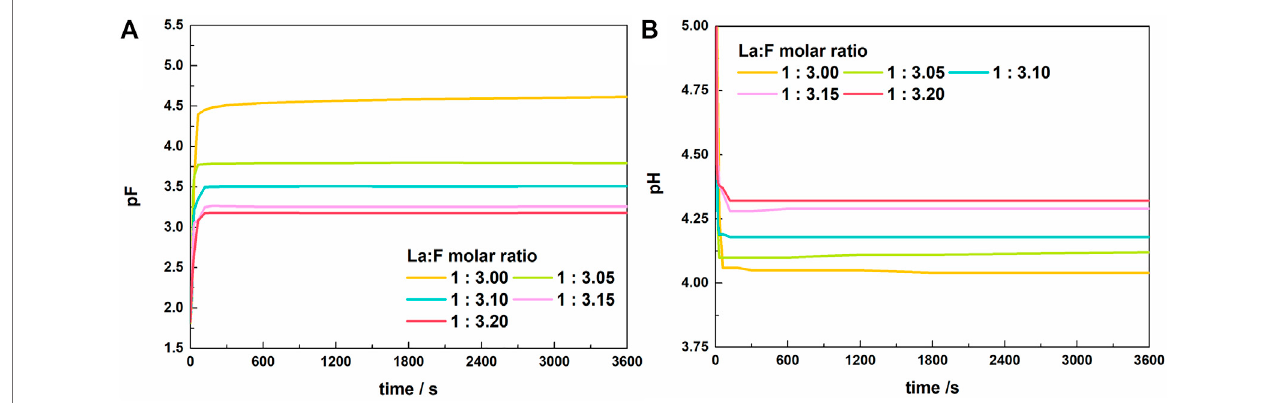
FIGURE3 | Variations ofpF (A) and pH (B) ofthe solutions with time after addinglanthanumnitrate to the fl uorine-containing synthetic solutions withdifferentLa/F molar ratios (La/F ≤ 1:3.00).